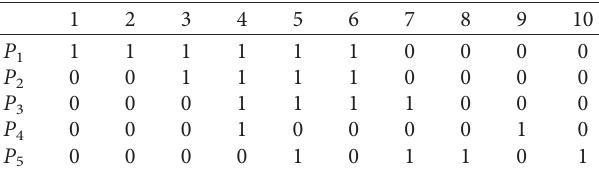
Table 3: Demand of parts per cycle.